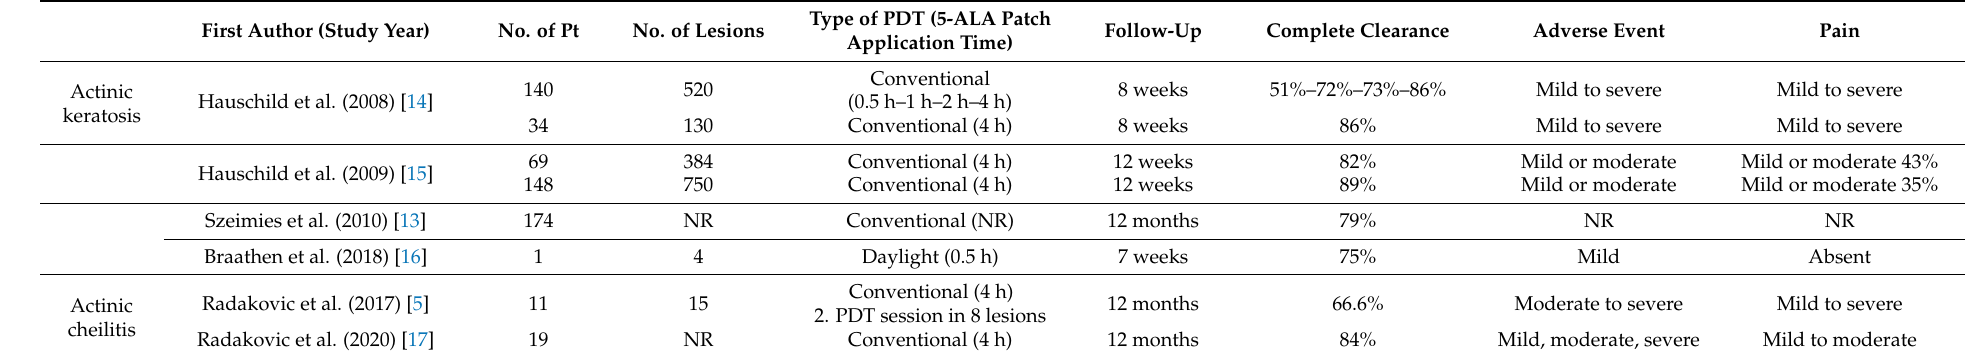
Table 1. Data about actinic keratosis (AK) and actinic cheilitis (AC) treated with 5-aminolevulinic acid (5-ALA) patch photodynamic therapy (PDT) according to the included